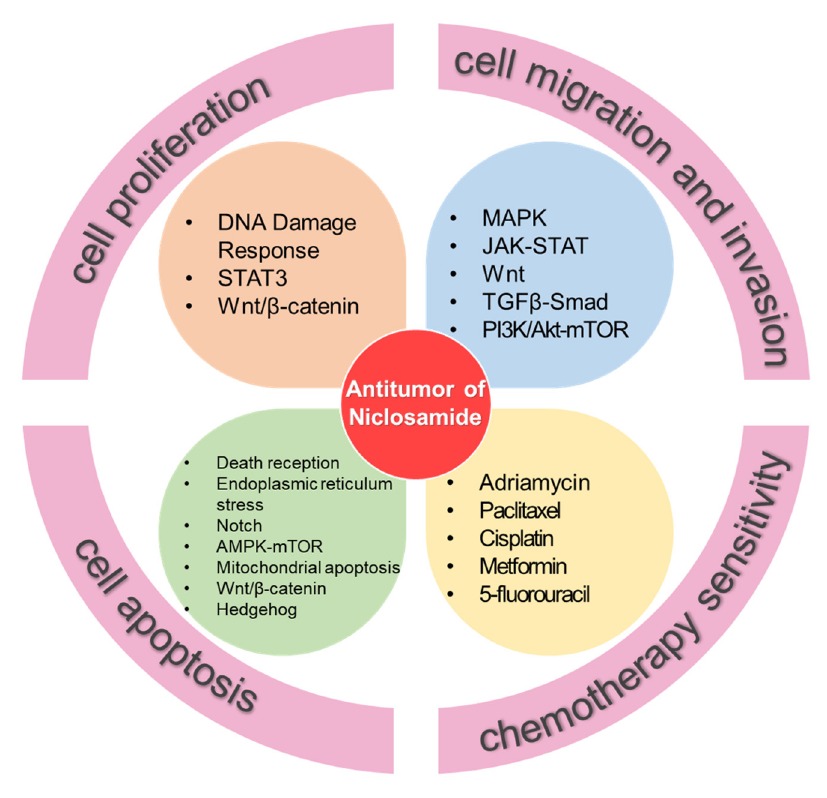
Figure 3. The anti-tumor activity and mechanism of